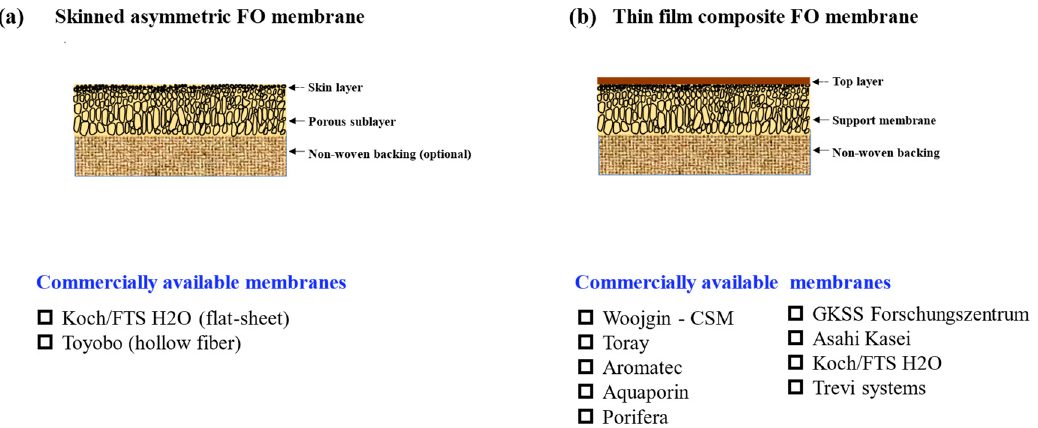
Figure 4. Illustration of the structure disparity of skinned asymmetric membrane ( a ) and TFC mem- brane ( b ) and the current commercially available membranes of each type. membrane ( b ) and the current commercially available membranes of each